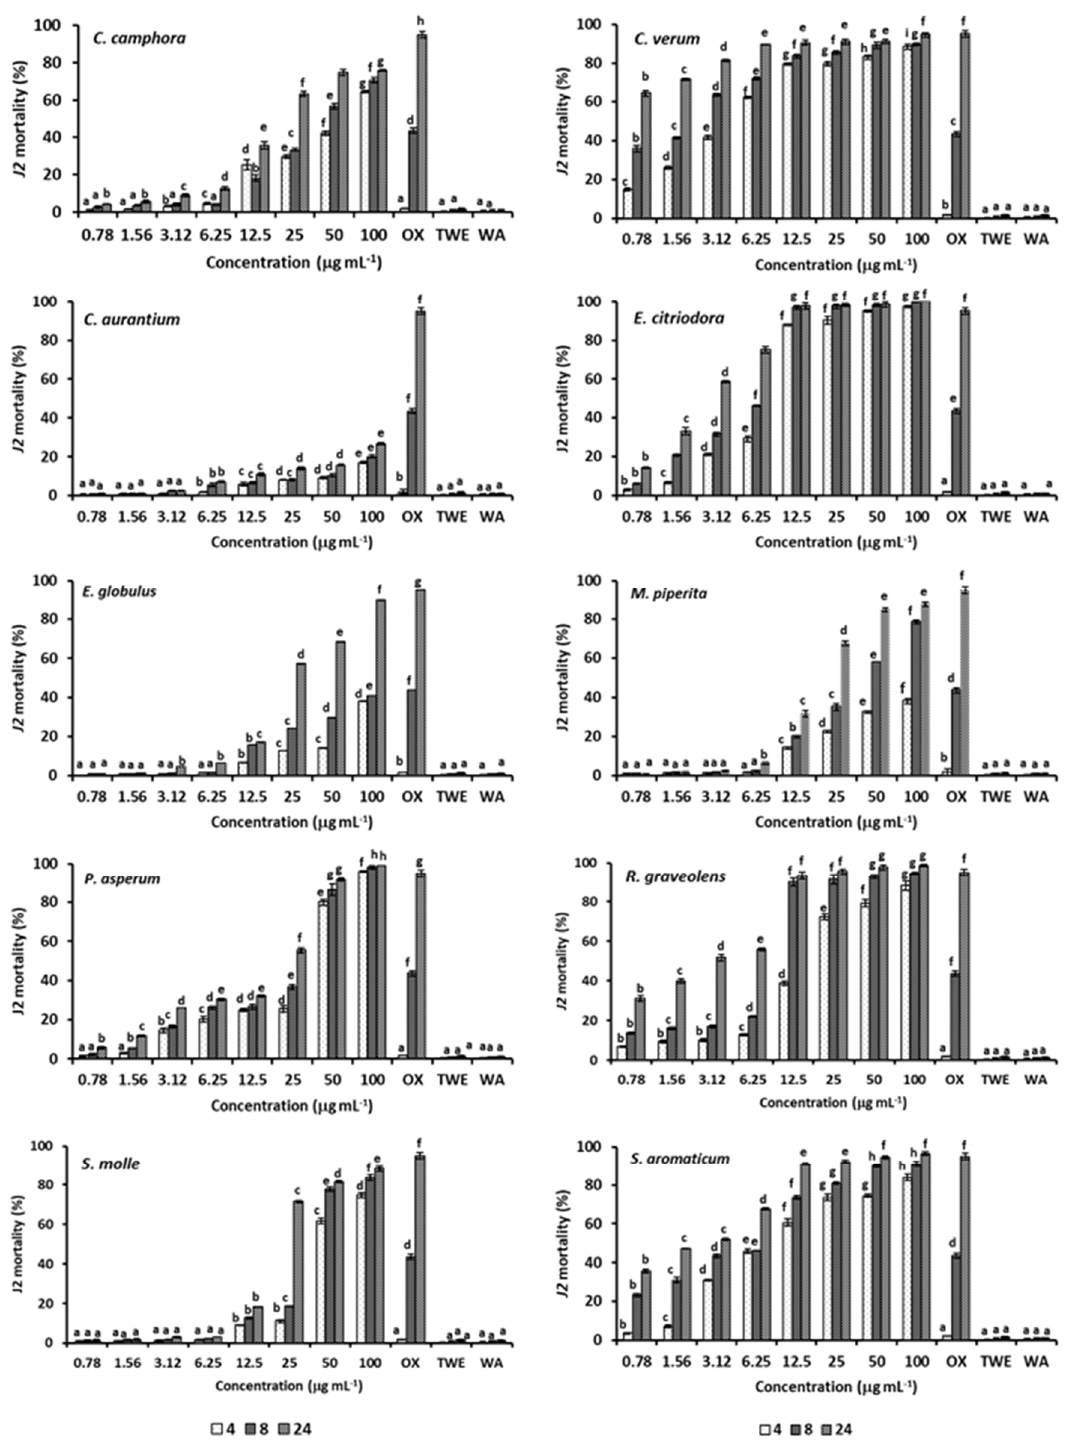
Figure 2. Mortality (%) of M. incognita J2 after 4, 8 or 24 h exposure to a 0.78–100 µg mL −1 range of concentrations of the ten tested EOs. Data are means of four replicates. At each exposure time, bars marked with the same letter are not significantly different ( p ≤ 0.05) according to the least significant difference test.